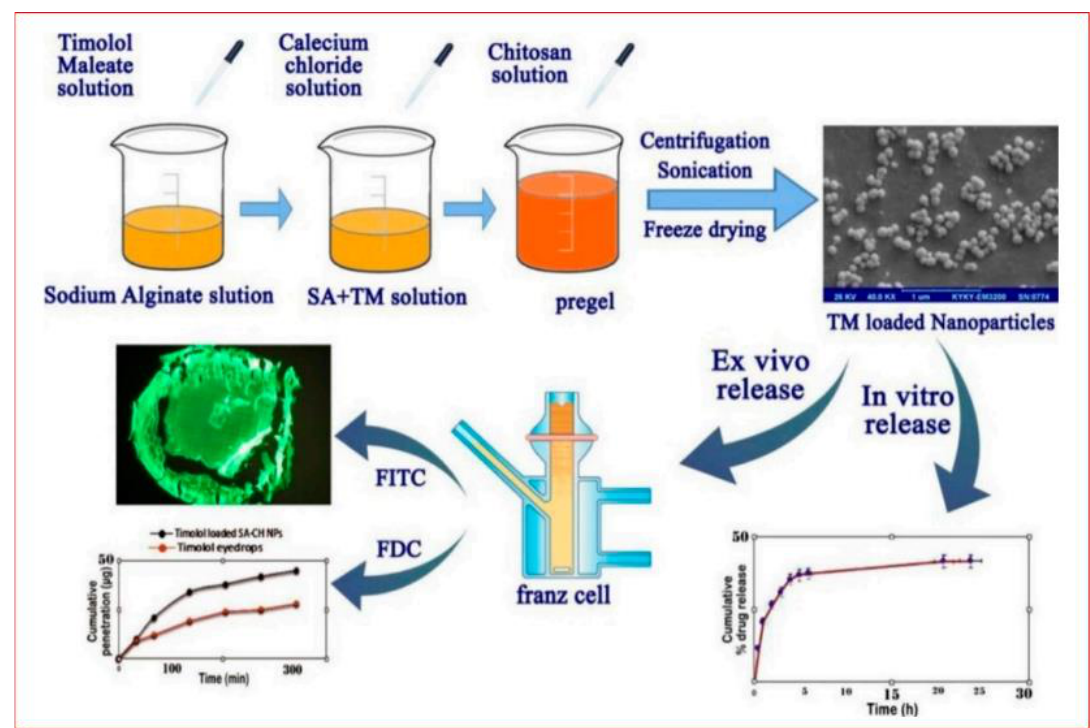
Figure 5. The synthesis of diclofenac sodium-loaded-N-trimethyl chitosan nanoparticles and application of them for ophthalmic usage. Figure adapted from Ref. [65].